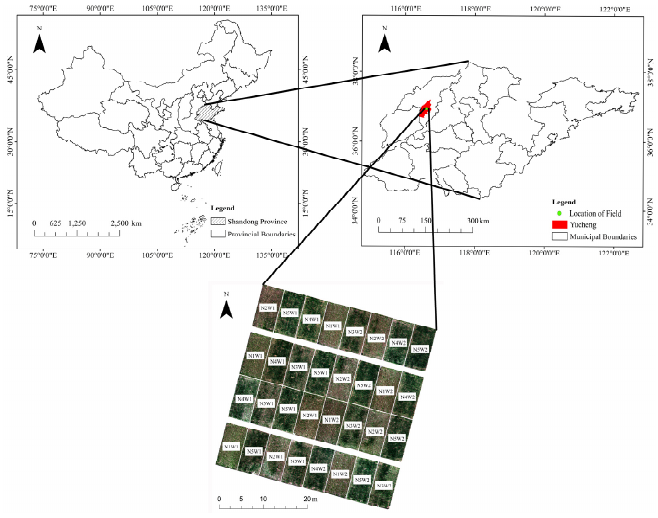
Figure 1. A schematic diagram of the water and nitrogen coupling experiment (W1: 80% field ca- pacity; W2: 60% field capacity; N1: no fertilizer; N2: 70 kg N/ha; N3: 140 kg N/ha; N4: 210 kg N/ha; N5: 280 kg N/ha).